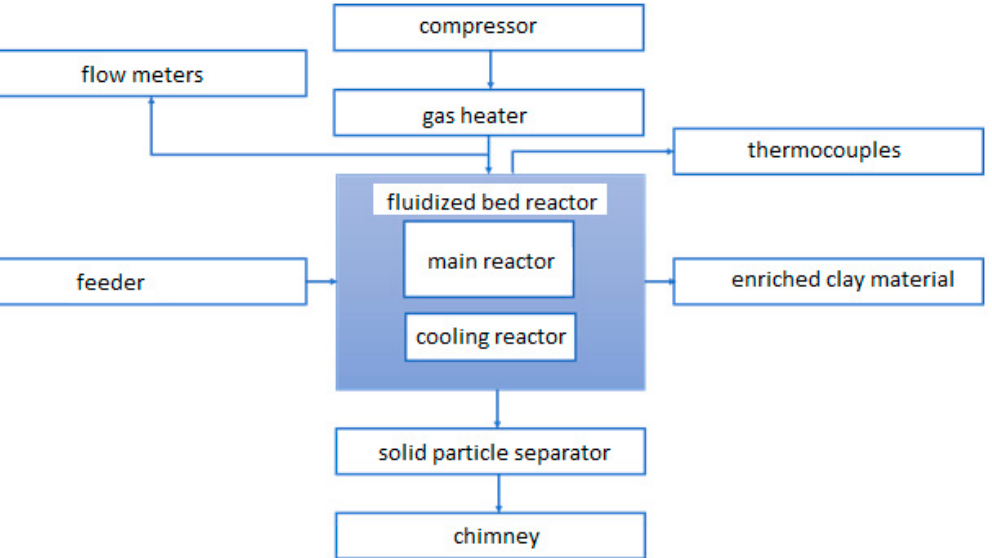
Figure 7. Block diagram of the stand for fluidized calcination of clay material.